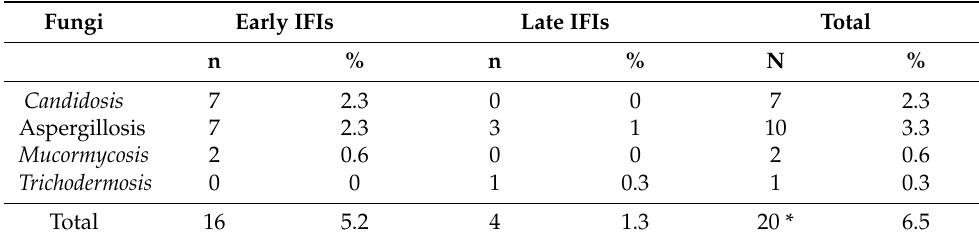
Table 2. Incidence of early and late IFIs depending on to the fungus among the 308 pediatric aHCT